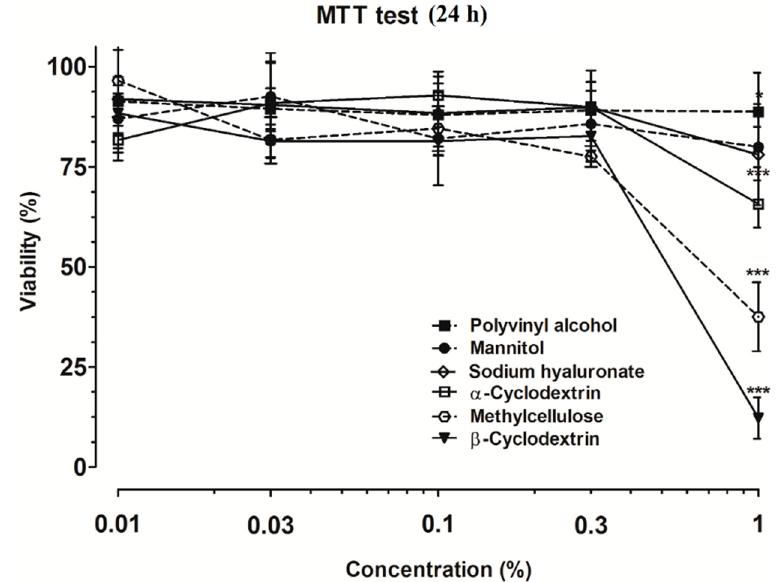
Figure 1. Toxicity of different excipients on RPMI 2650 cells measured by 3-(4,5-dimethyltiazol-2-yl)- 2,5-diphenyltetrazolium bromide (MTT) dye conversion assay. All values presented are means ± SD, n = 4. Significant differences compared to the values measured in control group are indicated as * p < 0.05; *** p < 0.001.